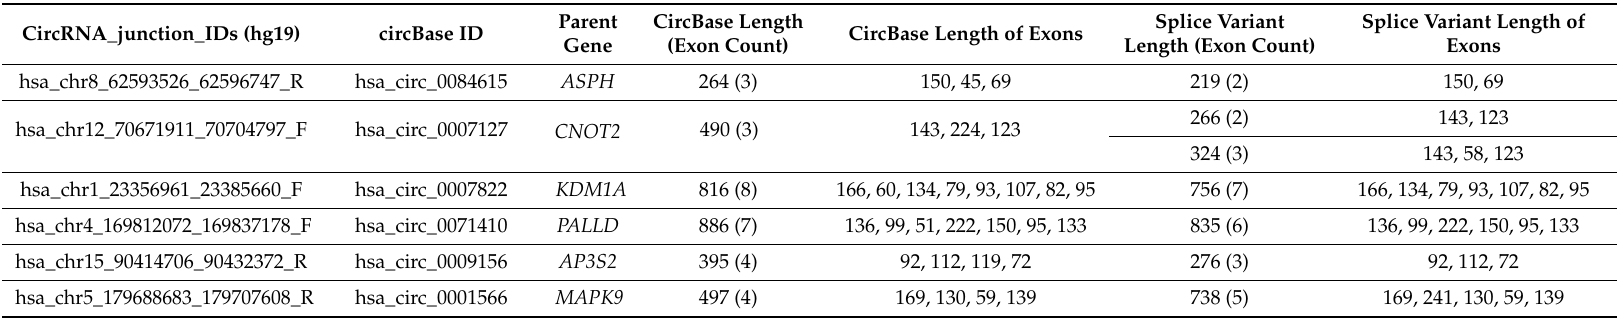
Table 1. circRNAs analyzed for splice variant expression in HeLa cells. The exon counts for each circRNA splice variant are indicated in